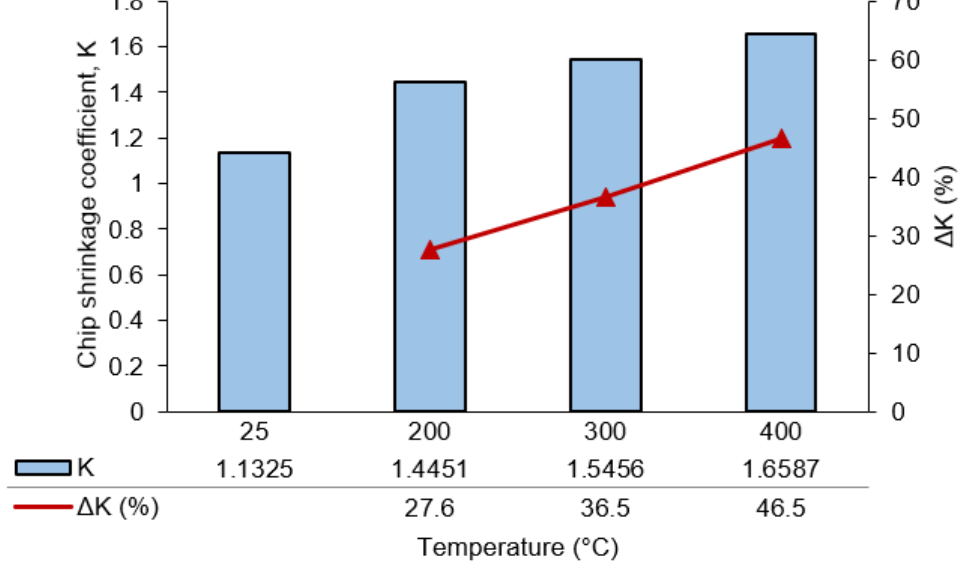
Figure 13. Chip shrinkage coe ffi cient and chip shrinkage increase during machining at various tem- Figure 13. peratures.